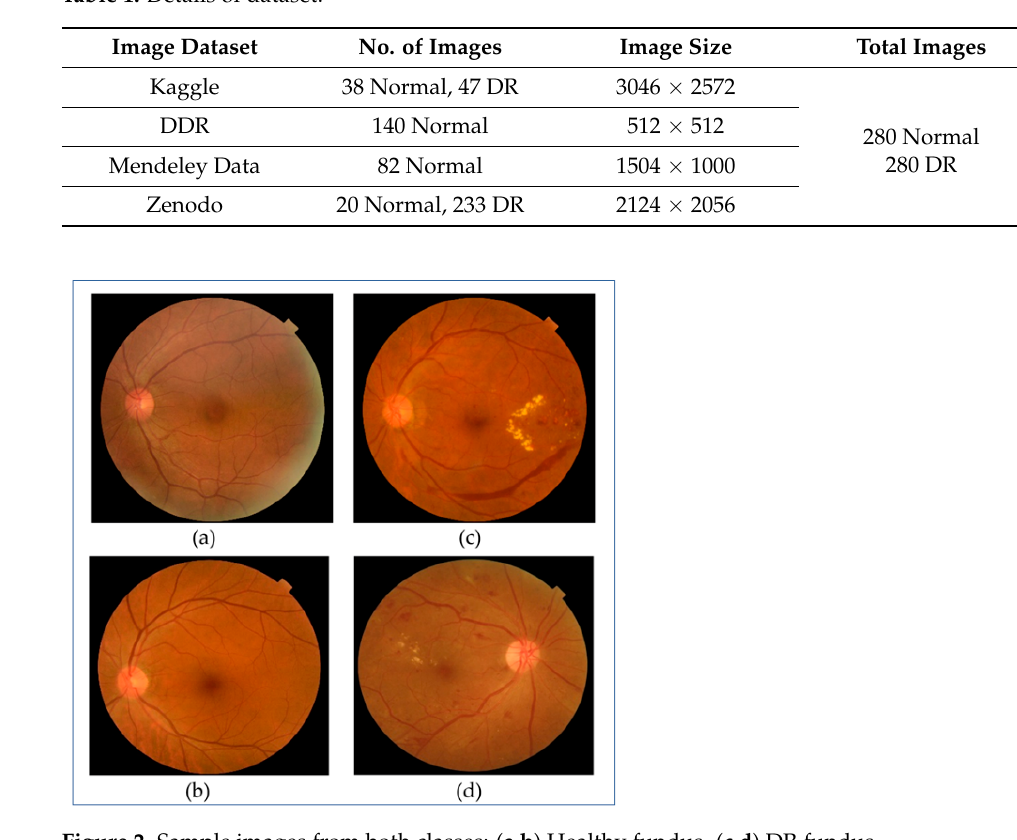
Figure 2. Sample images from both classes: ( a , b ) Healthy fundus. ( c , d ) DR fundus.